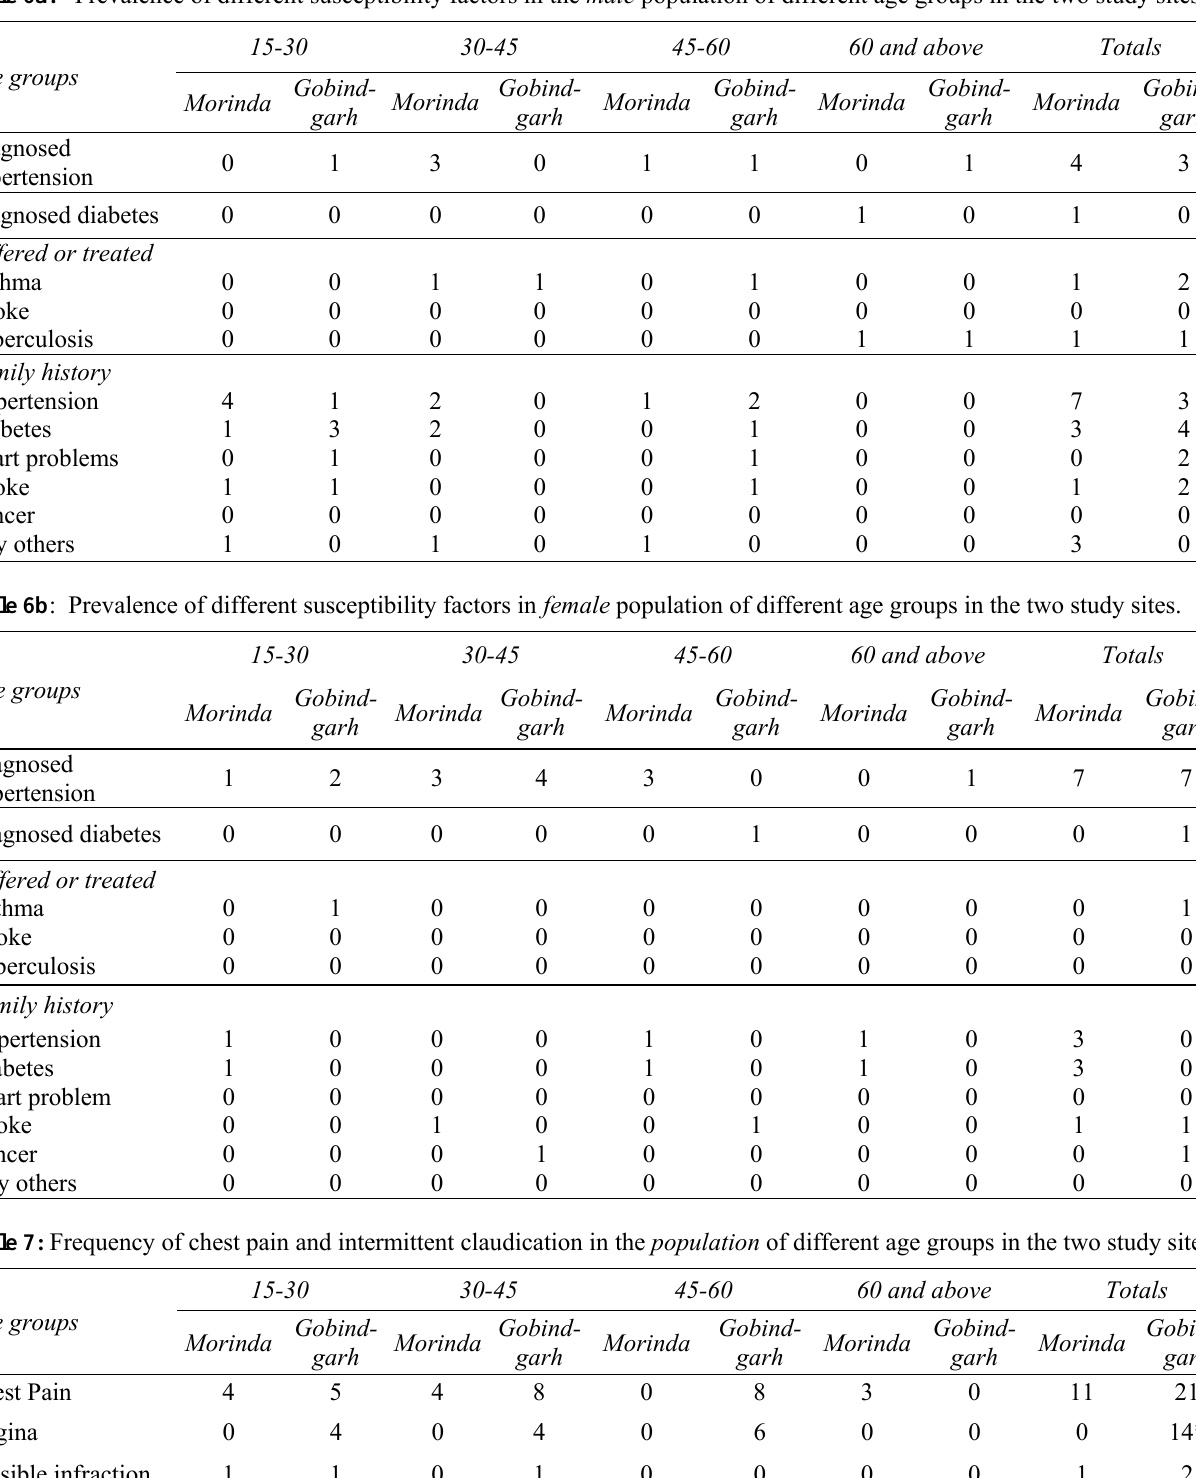
Table 6a: Prevalence of different susceptibility factors in the male population of different age groups in the two study sites. Age groups